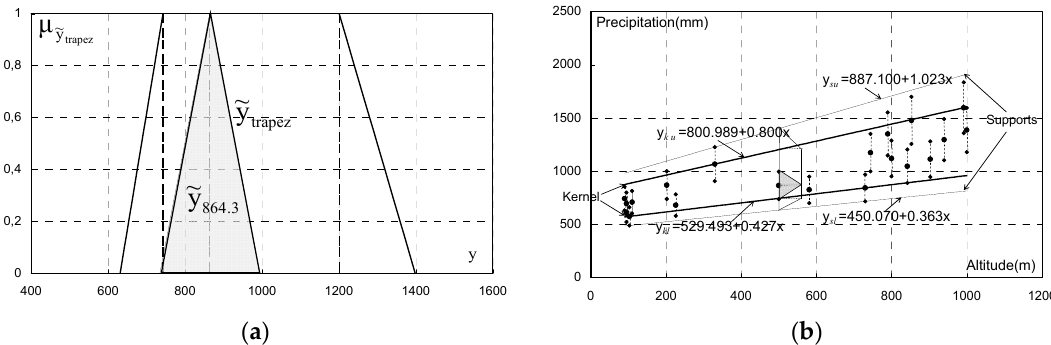
Figure 3. ( a ) Predicted parameters (cid:1827)(cid:4634) (cid:2868) , ( b ) Predicted parameters (cid:1827)(cid:4634) (cid:2869) .